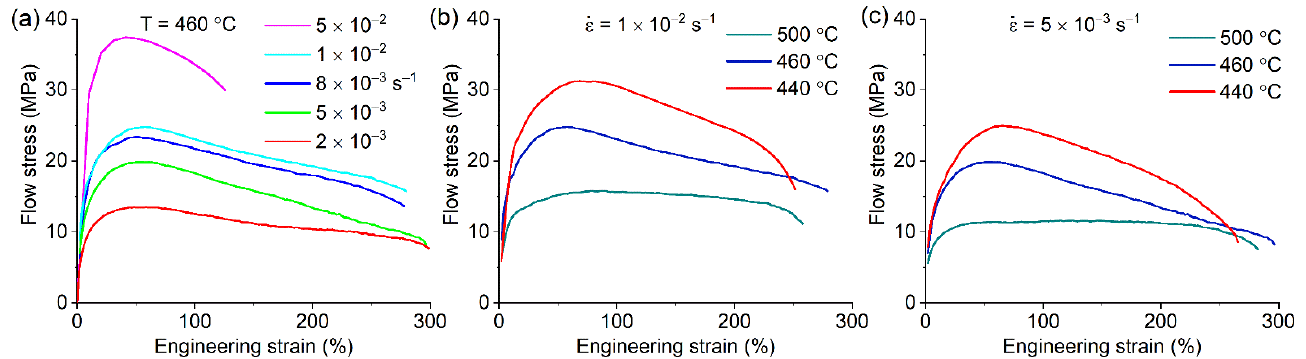
Figure 11. The flow stress-strain dependences for the reference Ni-free alloy at ( a ) 460 °C in a strain rate range of 1 × 10 −2 −5 × 10 −3 s −1 and at constant strain rates of ( b ) 1 × 10 −2 s −1 and ( c ) 5 × 10 −3 s −1 for 440, 460 and 500 °C.